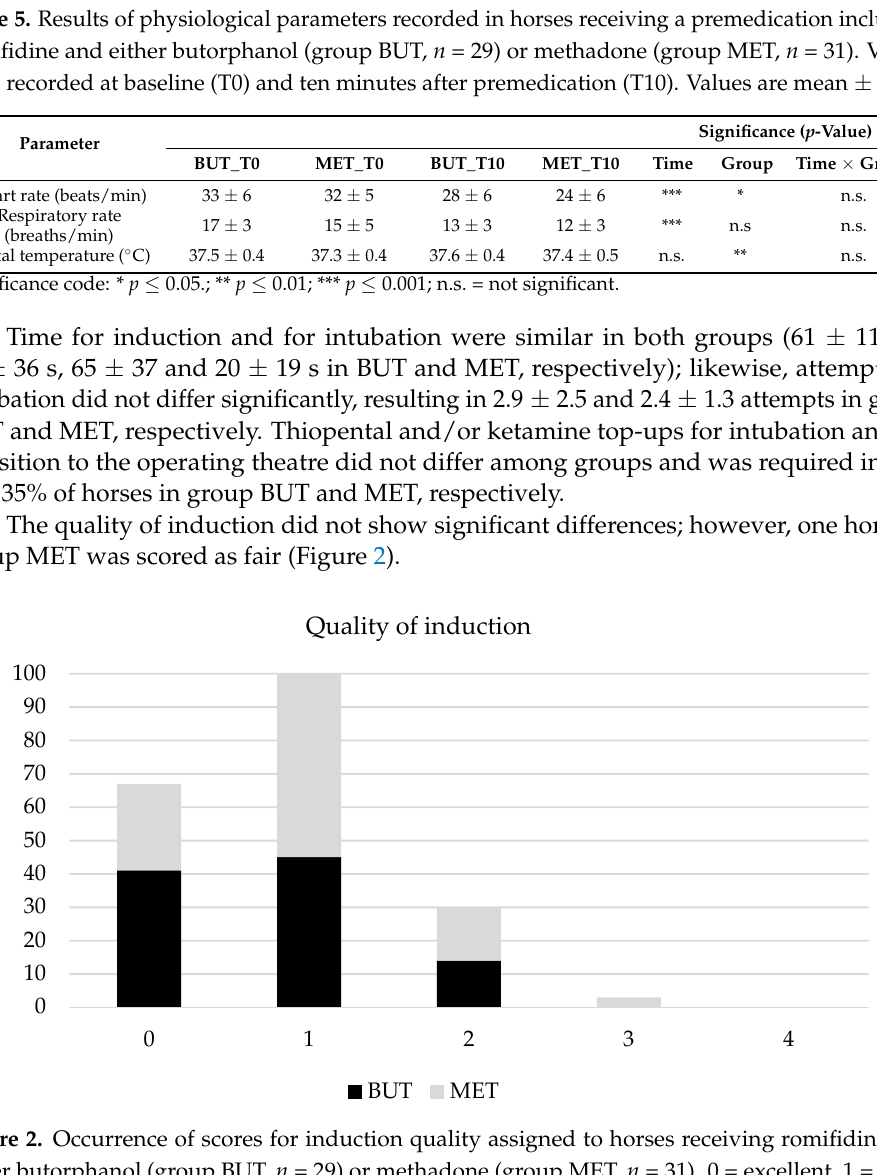
Table 5. Results of physiological parameters recorded in horses receiving a premedication including romifidine and either butorphanol (group BUT, n = 29) or methadone (group MET, n = 31). Values were recorded at baseline (T0) and ten minutes after premedication (T10). Values are mean ± SD. Parameter